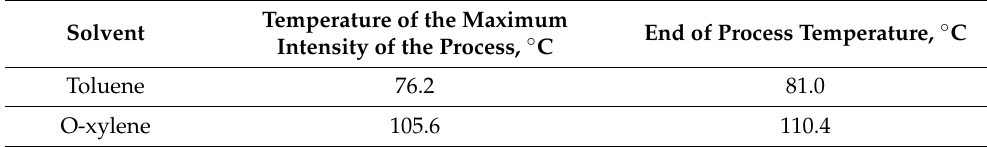
Table 6. Solvent’s thermal stability